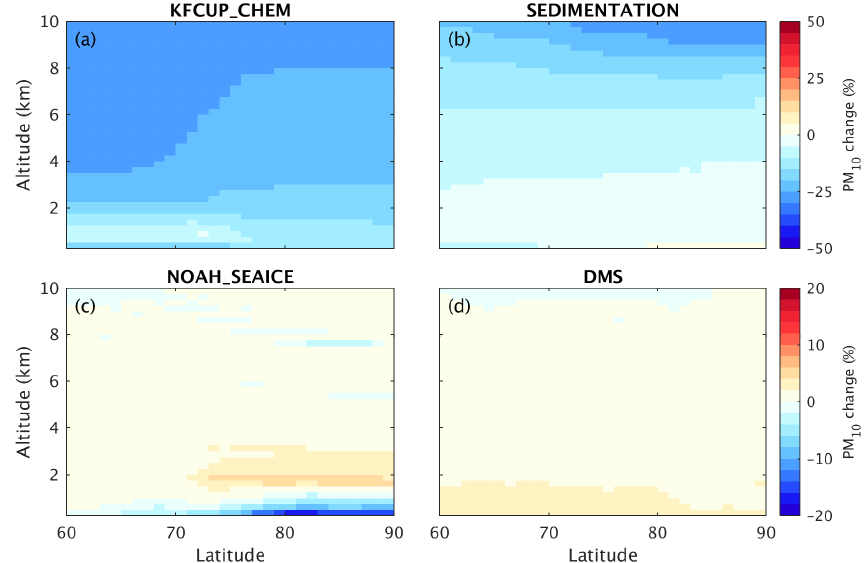
Figure 5. Change in the April–July 2008 average zonal mean PM 10 due to (a) KF-CuP cumulus effect on aerosols and trace gases, (b) aerosol sedimentation aloft, (c) the sea-ice-melt heat sink in the Noah LSM, and (d) DMS emissions and chemistry. Note the differences in scale between top and bottom